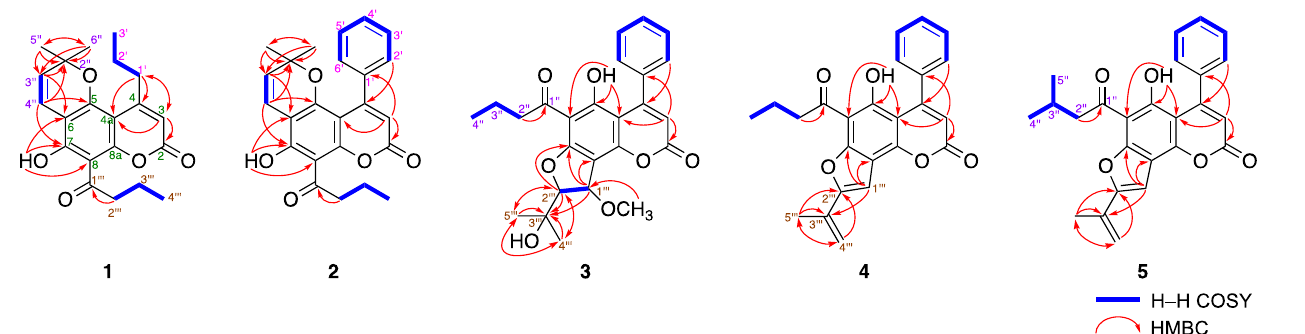
Figure 2. 1 H– 1 H COSY and HMBC correlations of 1 – 5 .